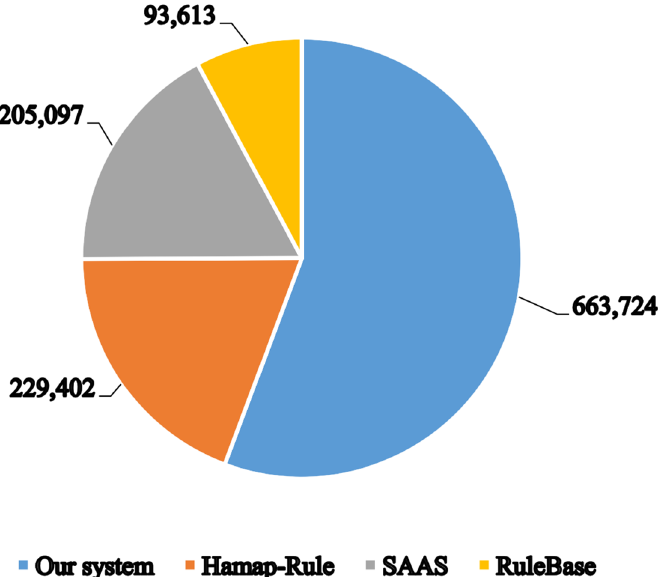
Fig 2. Comparison of annotation coverage of UniProtKB/TrEMBL reference proteome prokaryotic entries with three main automatic annotation systems present in UniProtKB/TrEMBL which are SAAS, HAMAP-Rule, and